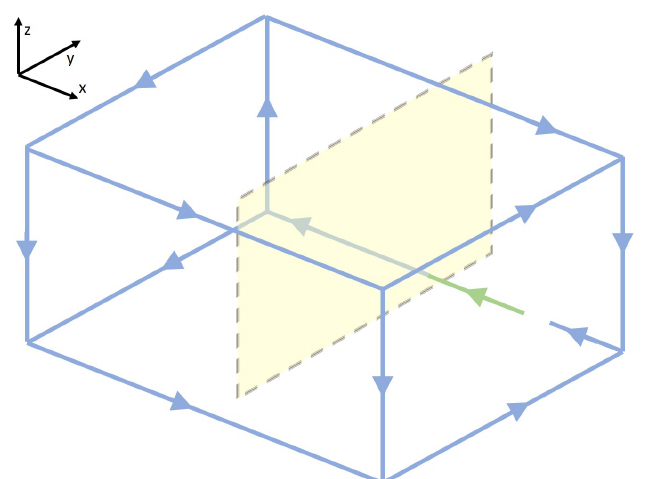
Figure 4: A layer swap domain wall (in yellow) swaps a lineon from the first X-cube layer (green) to the second layer (blue). Clearly operators which pass through the domain wall an odd number of times cannot form closed cages and so incur an energy penalty. Cage operators that stabilize the ground space are hence required to wind around the defect surface an even number of